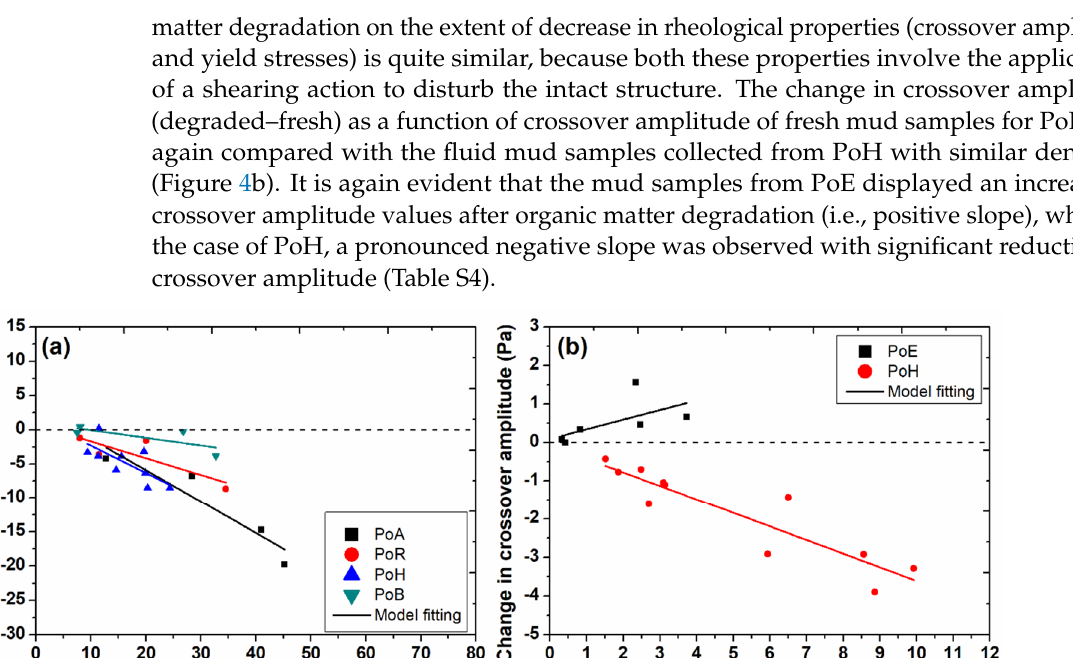
Figure 5. Percent change in crossover amplitude (cid:4672) (cid:3031)(cid:3032)(cid:3034)(cid:3045)(cid:3028)(cid:3031)(cid:3032)(cid:3031) – (cid:3033)(cid:3045)(cid:3032)(cid:3046)(cid:3035) different ports. 1.5IQR, factor 1.5 of the interquartile range (25~75%). Negative values represent the percent decrease in crossover amplitude, while positive values represent the percent increase in crossover amplitude after degradation.